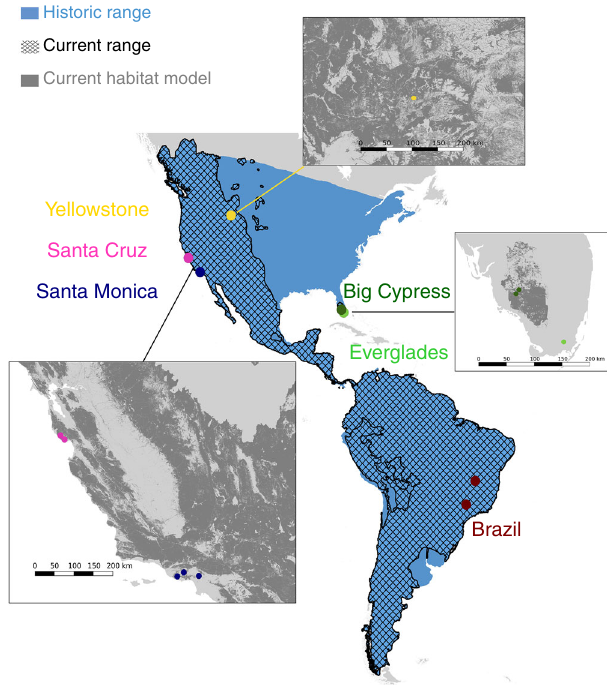
Fig. 1 Puma range past and present. The current range of pumas (hashed) compared to their historic range (blue). Circles denote the geographic coordinates of the puma populations sampled in this study. Panels show zoom-ins of puma habitat distribution (dark gray) within the known range of the species in the contiguous United States as predicted by the USGS 59 . Current range data are from the IUCN Red List of Threatened Species 60 . Historic range data are approximated based on prior reports 12 . Base map generated with Natural